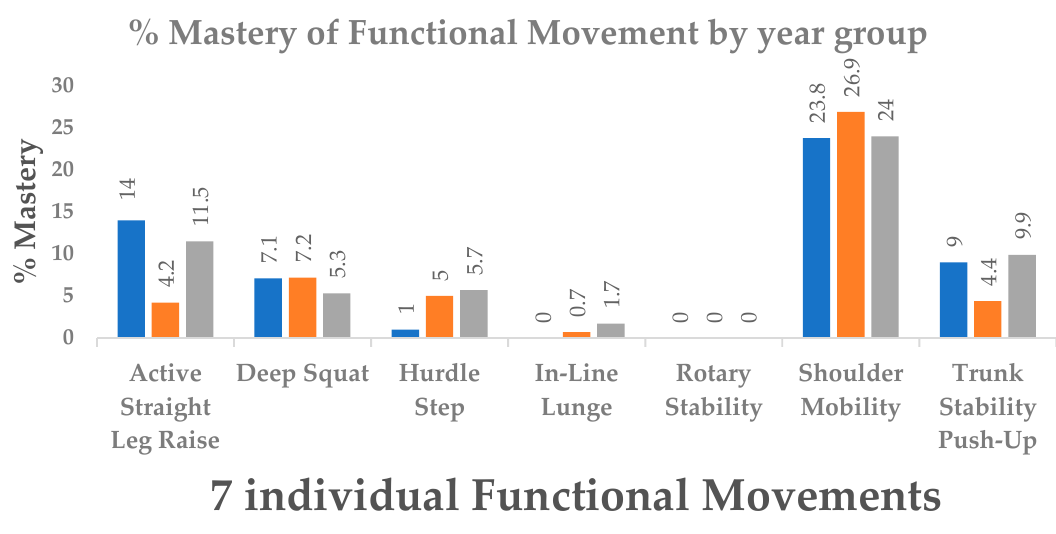
Figure 2. The prevalence of functional movement mastery by school year group among participants.